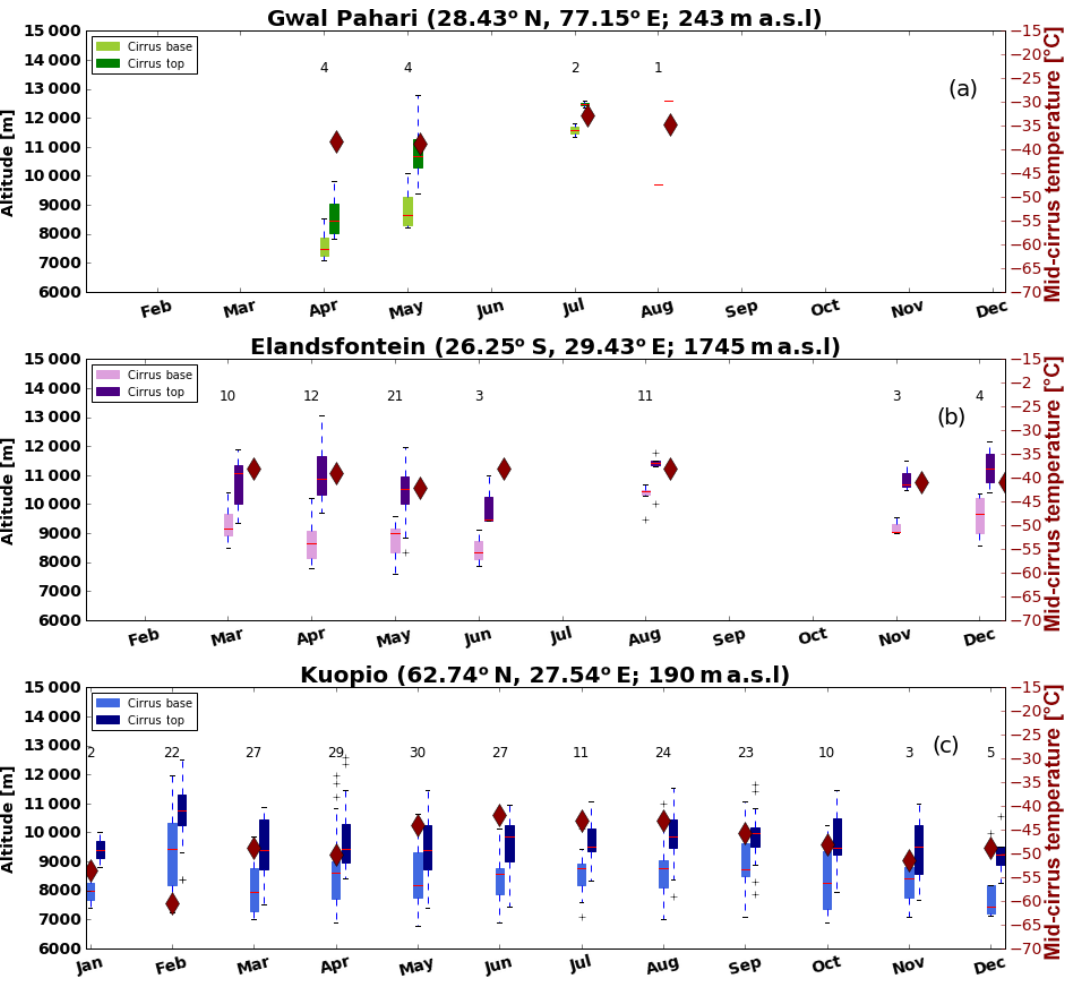
Figure 4. Monthly cycle of the mean cirrus base and top and the corresponding middle-temperature values (rhombus) of the cirrus clouds at Gwal Pahari (a) , Elandsfontein (b) and Kuopio (c) . Horizontal line in box: median. Boxes: the upper and lower quartile. Whisker: extreme values. Numbers labelled indicate the number of cirrus cases per month. Table 2. Average cirrus properties for the three regions for daytime and nighttime